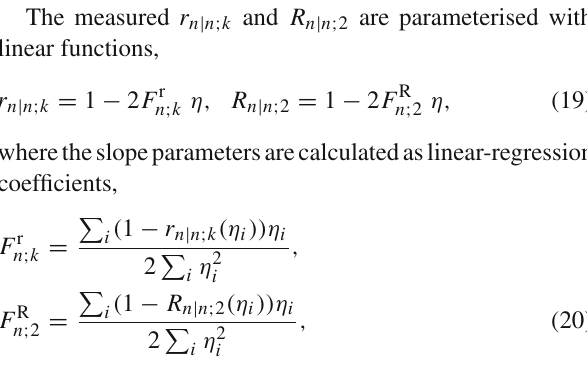
Fig. 10 The R 3 | 3 ; 2 (η) compared between the two collision energies. Each panel shows results from one centrality interval. The error bars and shaded boxes are statistical and systematic uncertainties,